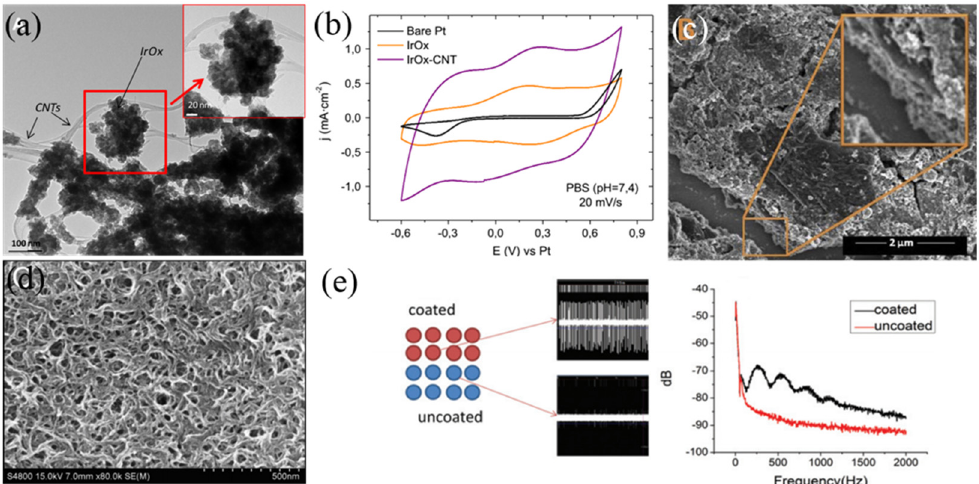
Figure 12. ( a ) TEM image of IrO x -CNT composite coating [127]; ( b ) Cyclic voltammetry (CV) curves of bare Pt, IrO x , and IrO x -CNT coated electrodes in PBS (pH = 7.4) at sweep rate of 20 mV · s − 1 [127]; ( c ) SEM image of IrO x -GO composite coating [129]; ( d ) SEM image of SWNT-PPy composite coating [130]; ( e ) Influence of peptide bond on PEDOT / PSS / MWCNT composite coating [131]. Reproduced from the mentioned references with permission from the related journals.